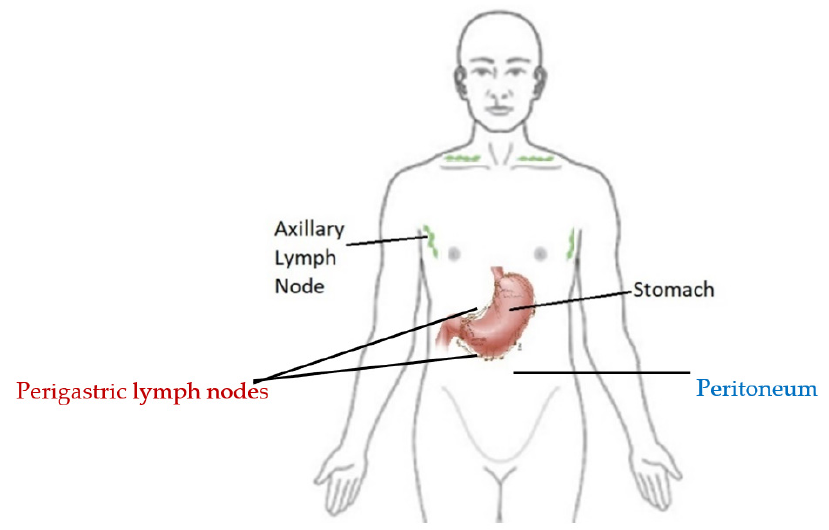
Figure 2. Pre-treatment biopsies of the gastric tumor and right axillary lymph node (black). First post-treatment biopsy of the peritoneum (blue); second post-treatment biopsy of the perigastric lymph nodes (red). Table 2. Pairwise clonality test of somatic alterations.